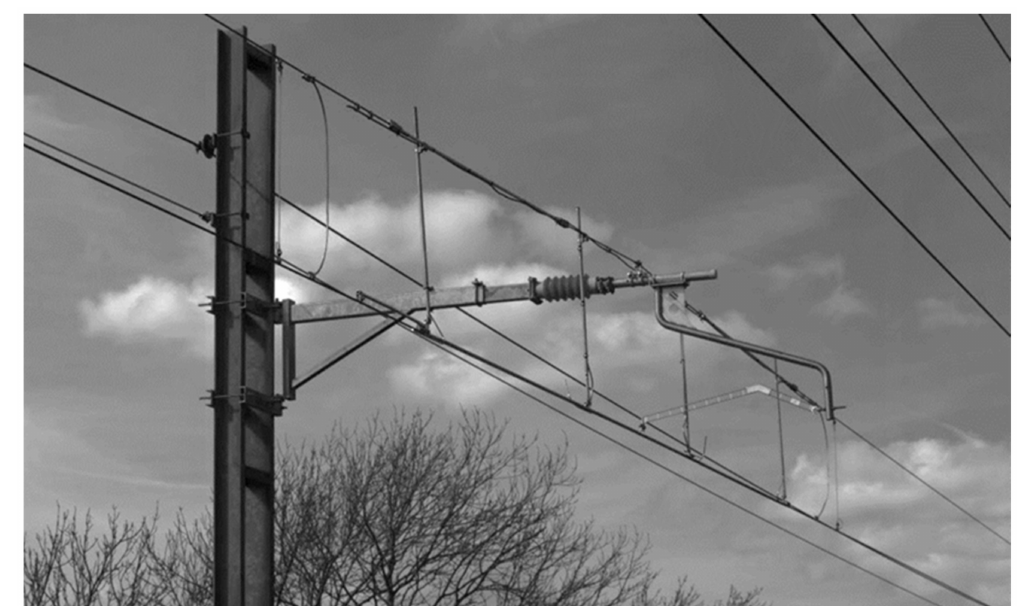
Figure 13. Neutral section installed at Melton (Old Dalby) from DBST trackside video